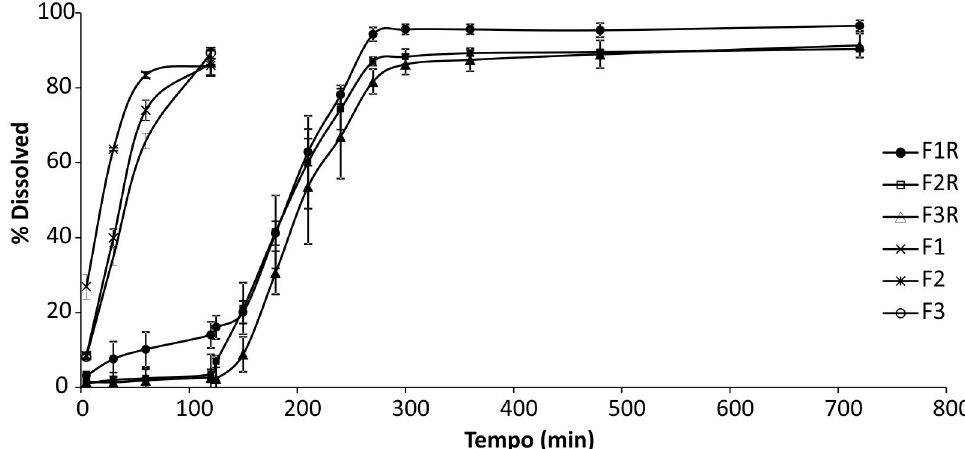
FIGURE 1 – Dissolution profiles of uncoated and coated formulations (mean ± SD; TABLE III – Pearson’s correlation coefficient (r), following linear dissolution data, and release exponent (n) (n=6) Formulation